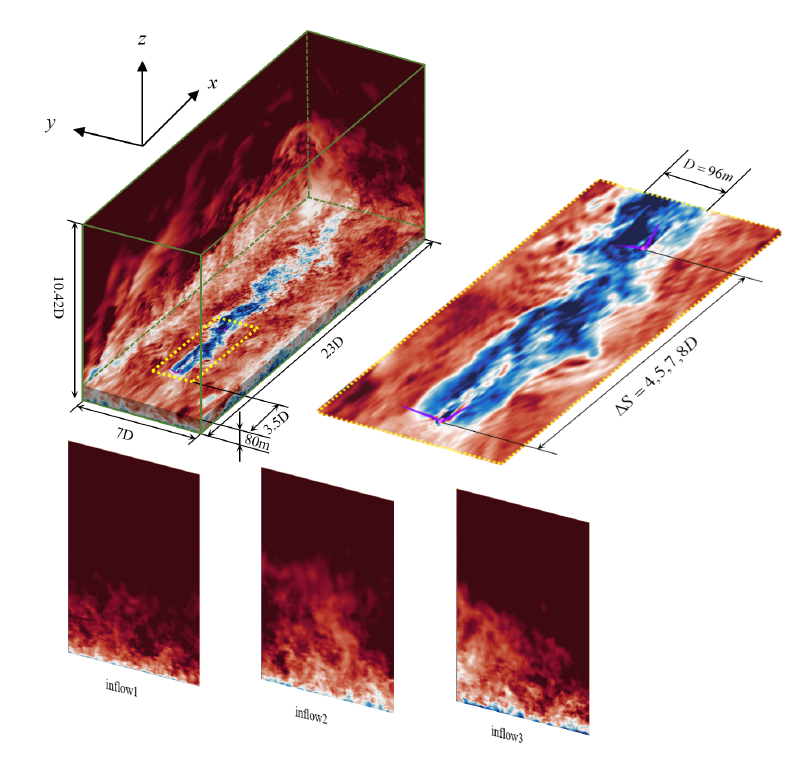
Figure 1. Schematic of the computational set-up of the simulated cases.